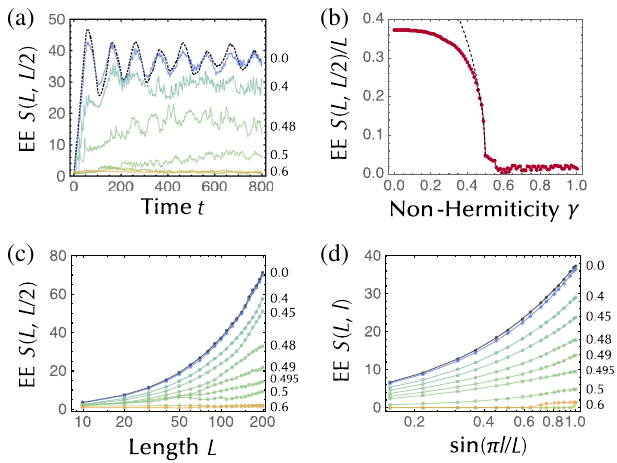
FIG. 11. Entanglement entropy of the symplectic Hatano- Nelson model with open boundaries ( J ¼ 1 . 0 , Δ ¼ 0 . 5 ). The initial state is prepared as Eq. (24). (a) Time evolution of the entanglement entropy S ð L; L= 2 Þ ( L ¼ 100 ) for γ ¼ 0 . 0 (black dashed curve), 0.2 (blue curve), 0.4, 0.48, 0.5 (green curves), 0.6 (light green curve), and 0.8 (orange curve). (b) Entanglement entropy density S ð L; L= 2 Þ =L ( L ¼ 100 ) for the steady state as a function of non-Hermiticity γ . The black dashed curve is the fitting result S ð L; L= 2 Þ =L ¼ 0 . 94 ð Δ =J − γ =J Þ 0 . 44 around the critical point γ ¼ Δ . (c) Entanglement entropy S ð L; L= 2 Þ for the steady state as a function of the system length L for γ ¼ 0 . 0 , 0.2, 0.4, 0.45, 0.48, 0.49, 0.495, 0.5, 0.6, and 0.8. (d) Entangle- ment entropy S ð L; l Þ ( L ¼ 100 ) for the steady state as a function of the subsystem length l .